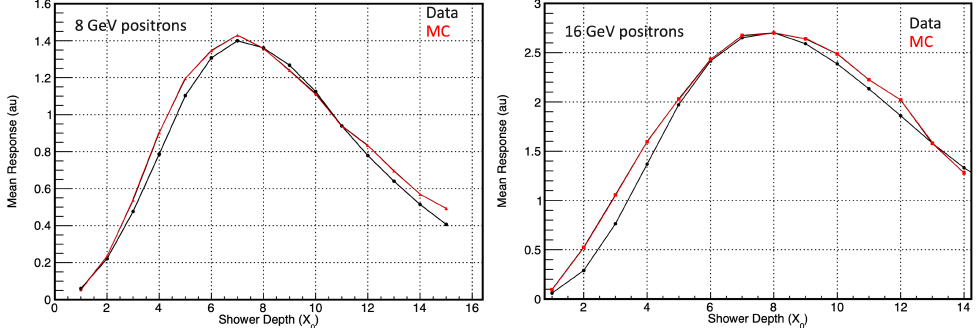
Figure 3. The response of the SE module to 8 ( left ) and 16 GeV ( right ) positrons with the tungsten absorbers.